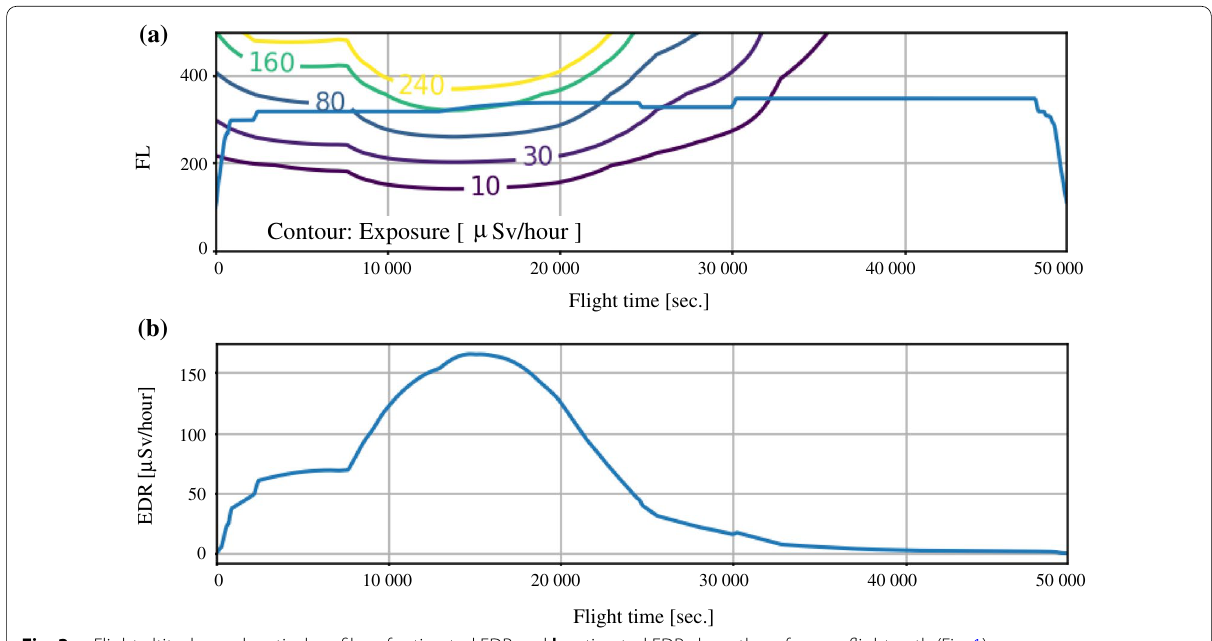
Fig. 3 a Flight altitudes and vertical profiles of estimated EDR and b estimated EDR along the reference flight path (Fig.